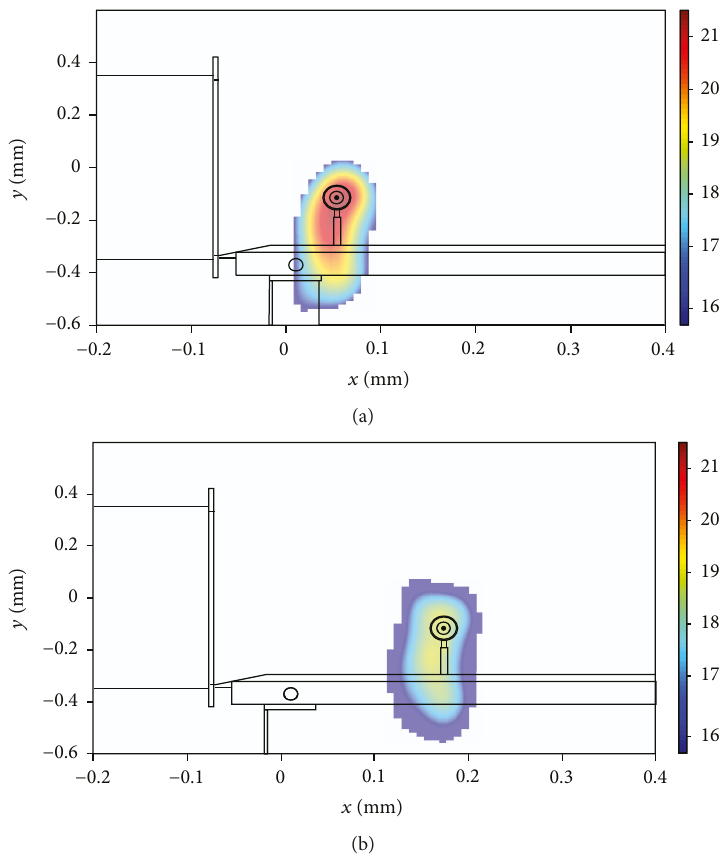
Figure 15: Beamforming results at 6100Hz: (a) Case 7; (b) Case